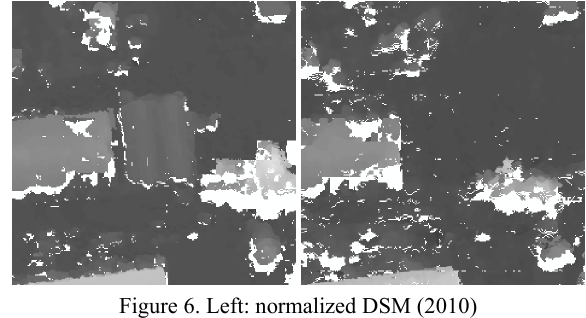
Figure 6. Left: normalized DSM (2010) Right: normalized DSM (2012) The Digital